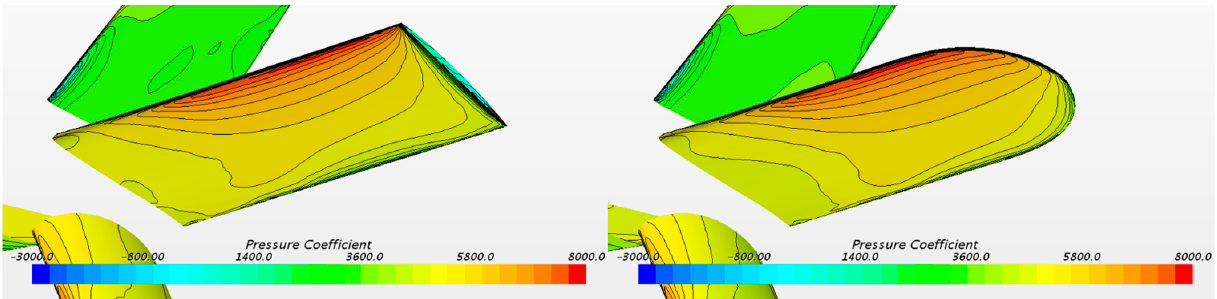
Figure 15. Comparison of the tip configuration and pressure distribution with and without the tip rounding treatment.